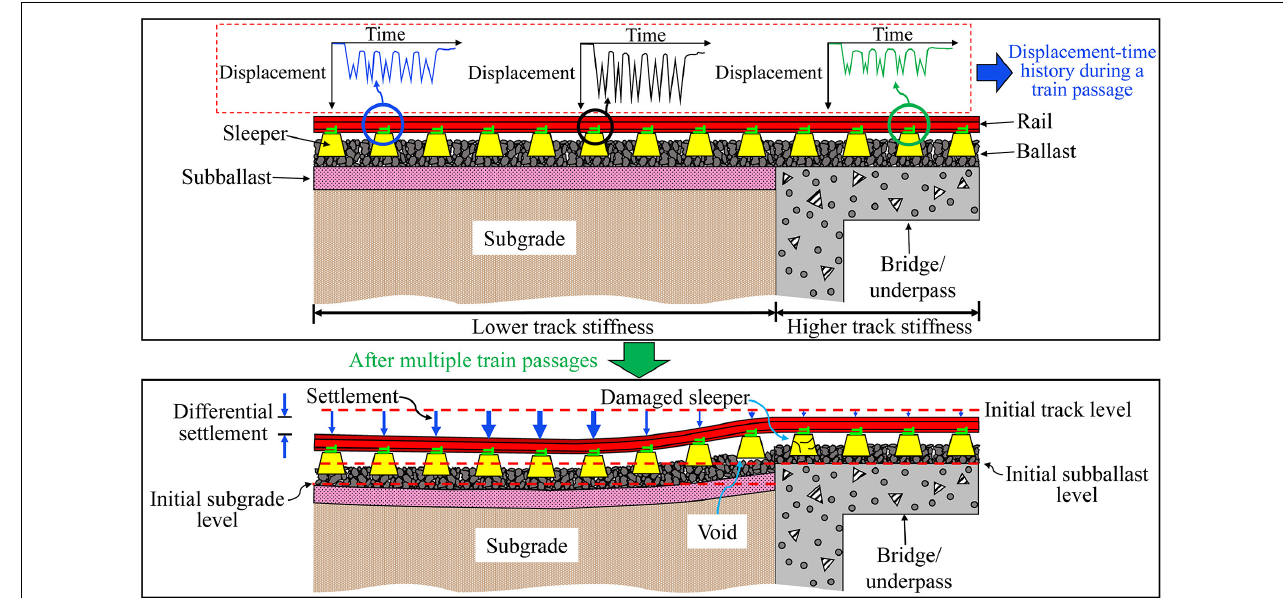
FIGURE 1 | Transition zone between an open track and stiff structure such as a bridge or underpass.